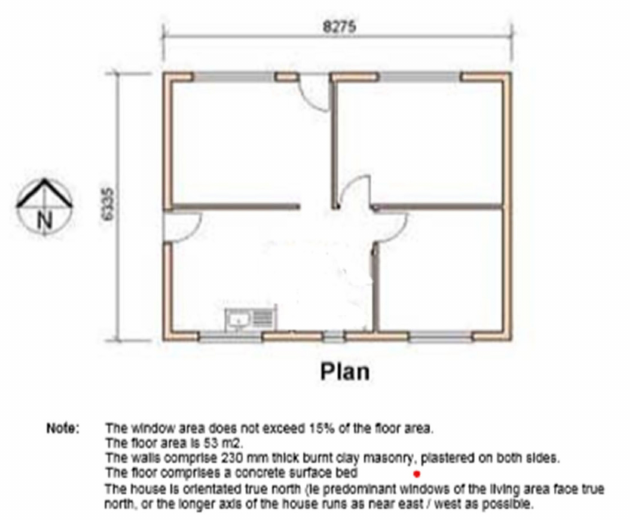
Figure 1. Floor plan of a common South African matchbox low-cost house dimensions slightly vary between locations however, main wall material (clay) remains constant. The average U-value of these homes is 42.56 W / m 2 ◦ K. (sourced from: http: // www.nhbrc.org.za / files / technical_docs / Design_and_